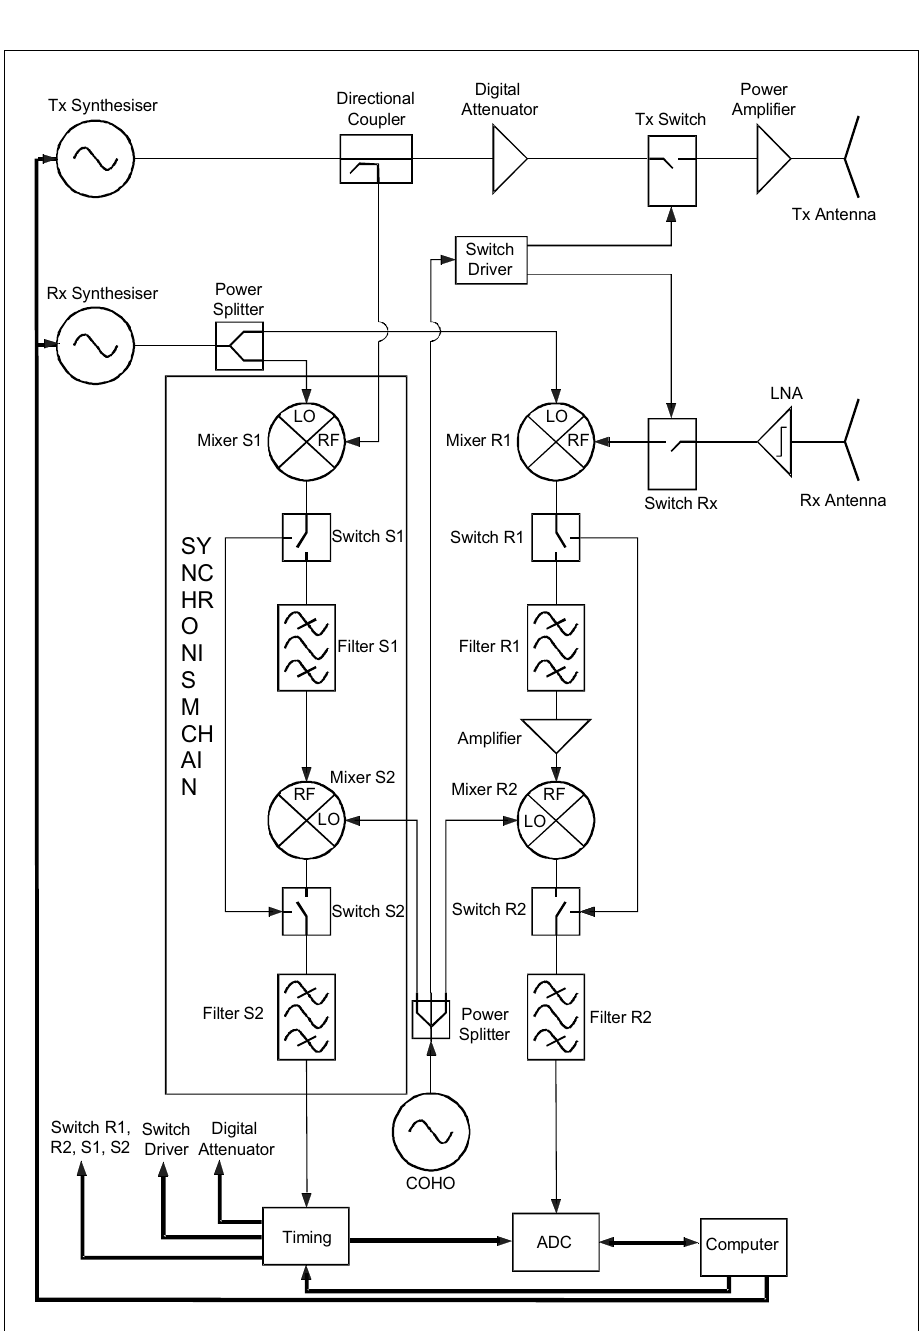
Fig. 1. Block diagram of the GPR